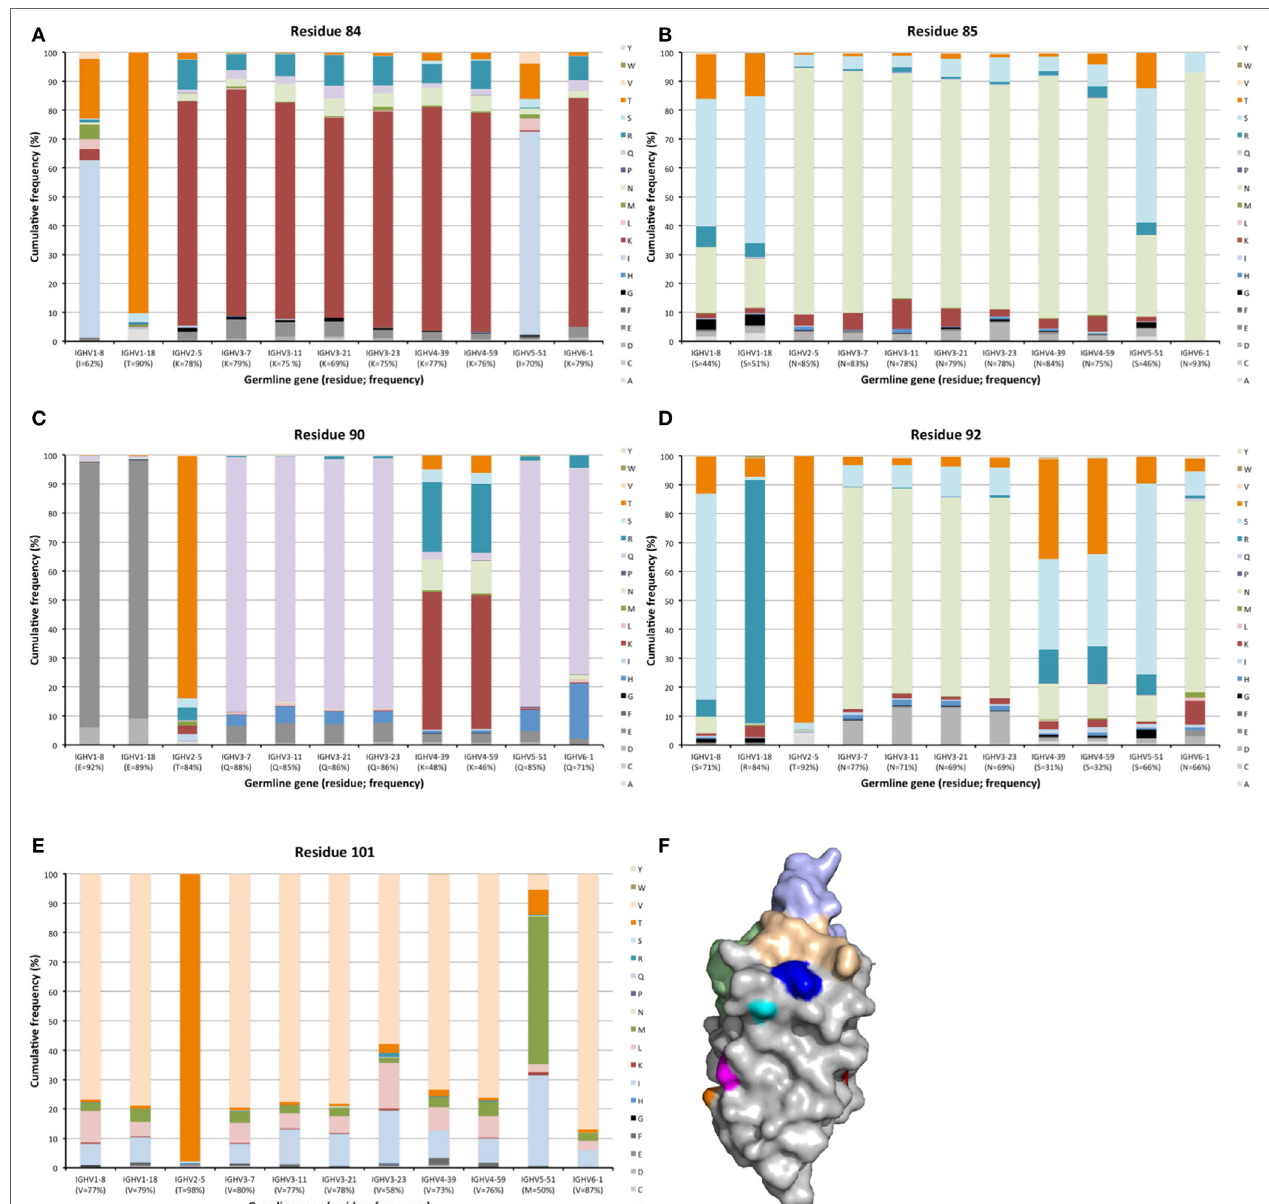
FigUre 10 | Substitutions of residues 84 (a) , 85 (b) , 90 (c) , 92 (D) , and 101 (e) in FR3 as introduced during somatic hypermutation processes of IgG-encoding genes derived from 11 different germline genes. Structure (F) of an IGHV5-51-derived scFv (PDB: 4BUH) indicating the side chain atoms of residues 84 (cyan), 85 (dark blue) in close proximity to CDR1, and of residues 90 (magenta), 92 (orange), and 101 (red). CDR are shown in brown (CDR1), green (CDR2), and light blue